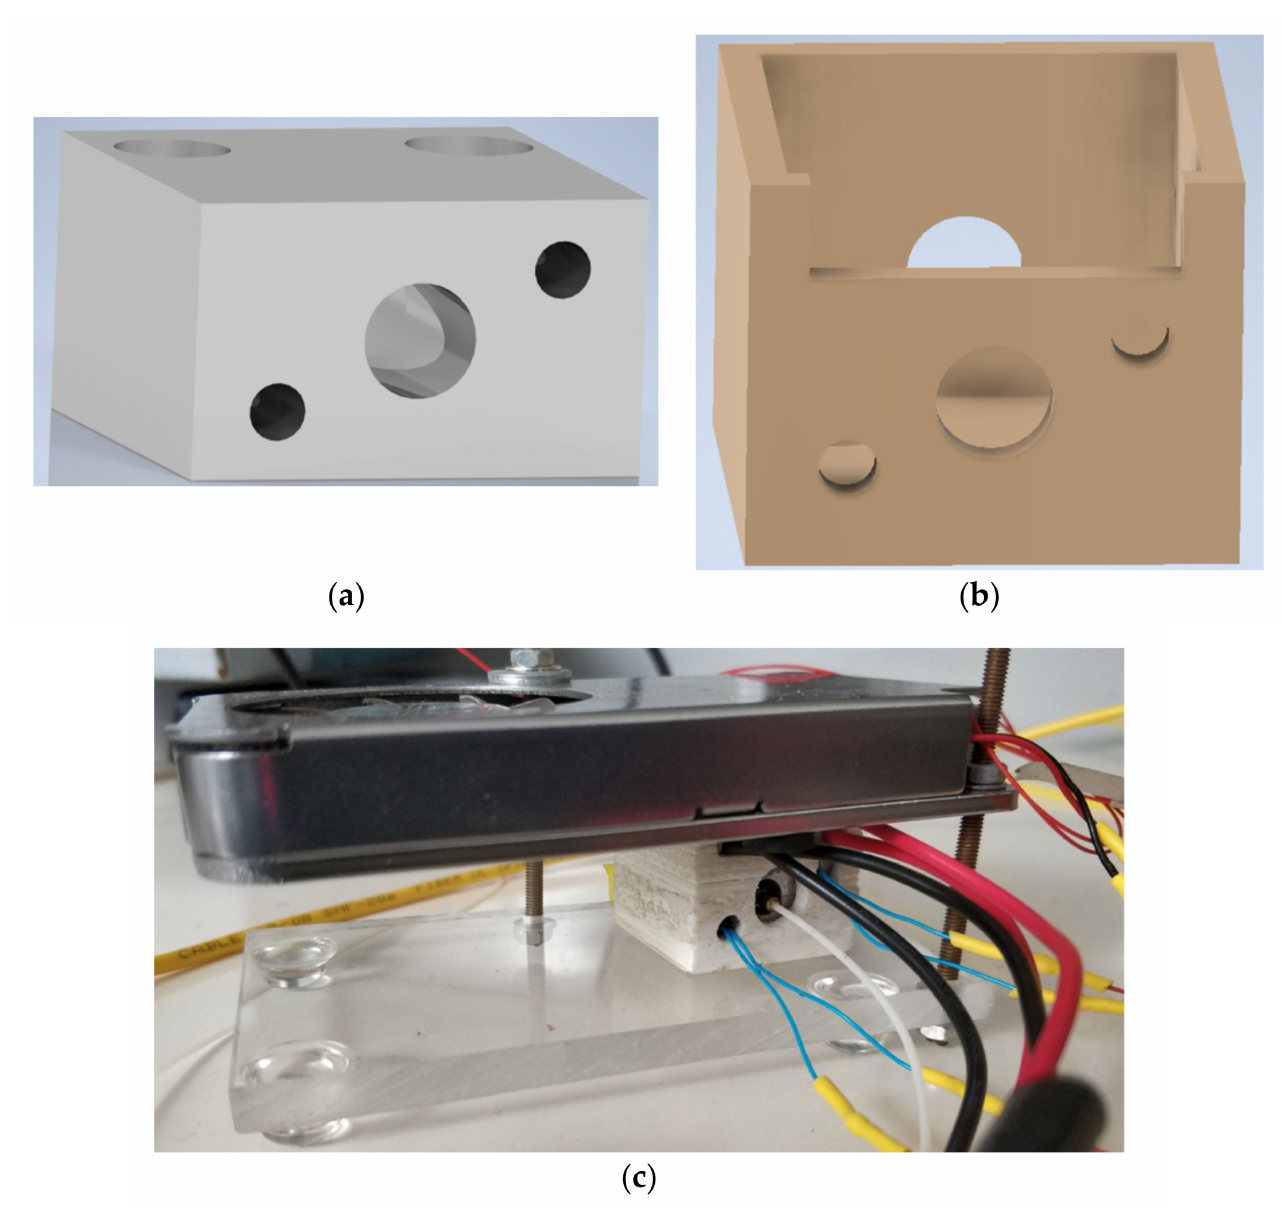
Figure 4. Images of: ( a ) Rendered aluminum block created to accommodate the laser diode and two thermistors; ( b ) rendered 3D printed shell to accommodate the aluminum block and contain possible condensations; ( c ) developed laser holding and enclosure